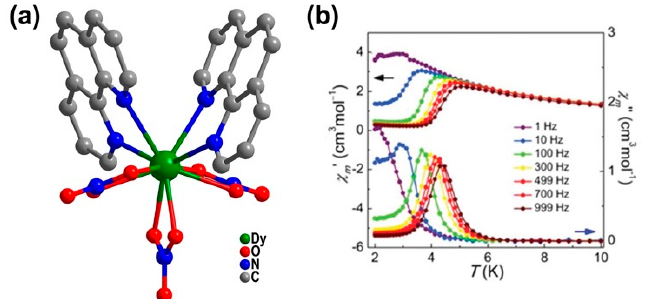
Figure 11. ( a ) Molecular structure and ( b ) temperature dependence of the in-phase ( χ ’) and out-of- phase ( χ″ ) AC susceptibilities for different frequencies at a DC field of 1500 Oe of 16 . Figures and captions are reproduced from Reference [44] with permission from the Royal Society of Chemistry.